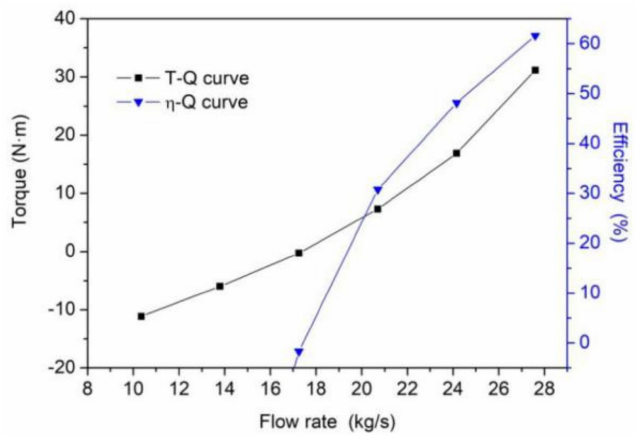
Figure 14. PAT performance in terms of torque and